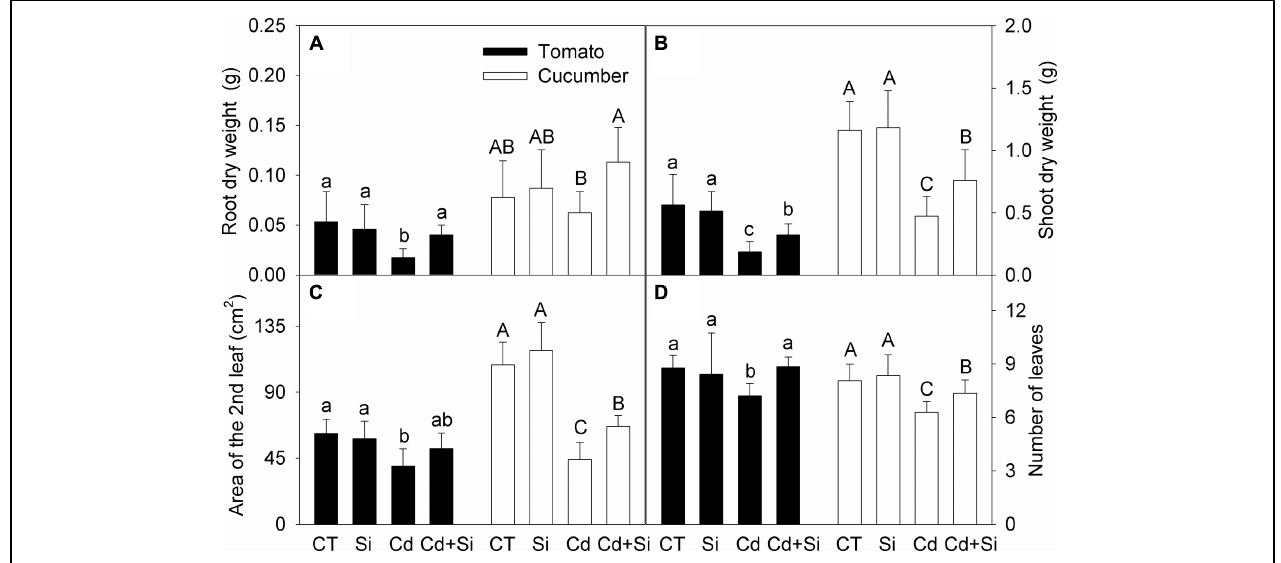
FIGURE 1 | Effects of silicon (Si) on dry weights of root (A) and shoot (B), the second leaf area (C) and total number of leaves (D) in tomato and cucumber plants under cadmium (Cd) stress. Bars with different letters means significant difference at P < 0.05 according to one-way ANOVA. Lower-case and upper-case letters indicate significance for tomato and cucumber, respectively.